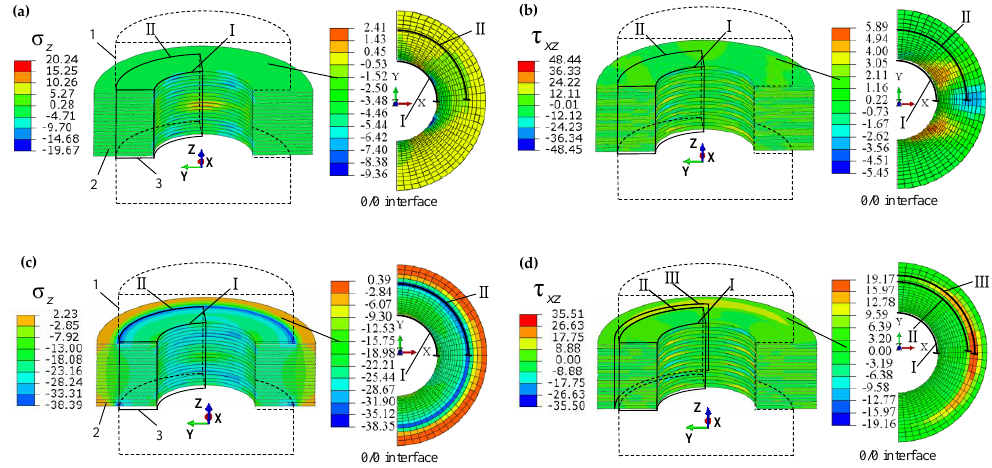
Figure 6. Stress distributions at the interface in the filled-hole laminate near the hole: ( a ) Interlaminar normal stress σ z , with non-tightened bolt; ( b ) Interlaminar shear stress τ xz , with non-tightened bolt; ( c ) σ z , with tightened bolt; ( d ) τ xz , with tightened bolt. 1—Bolt; 2—Interface; 3—Quarter clamp-up region; I—The hole edge; II—The projection boundary of the periphery of the bolt head on the